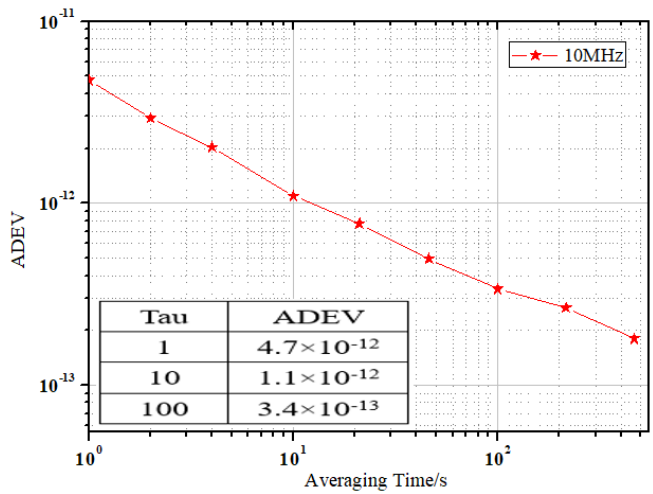
Figure 10. Comparison of TDEV using three devices.